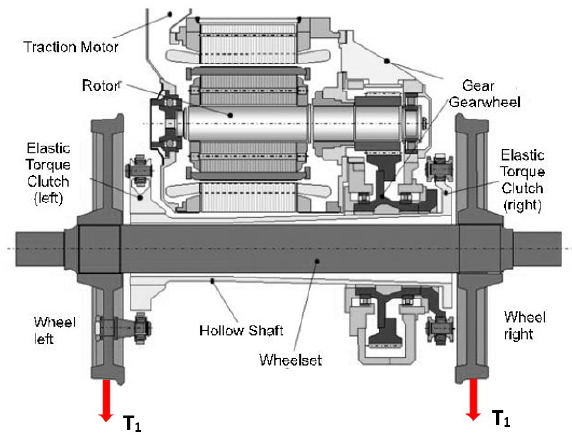
Figure 4. Visualization of wheel-rail forces – top